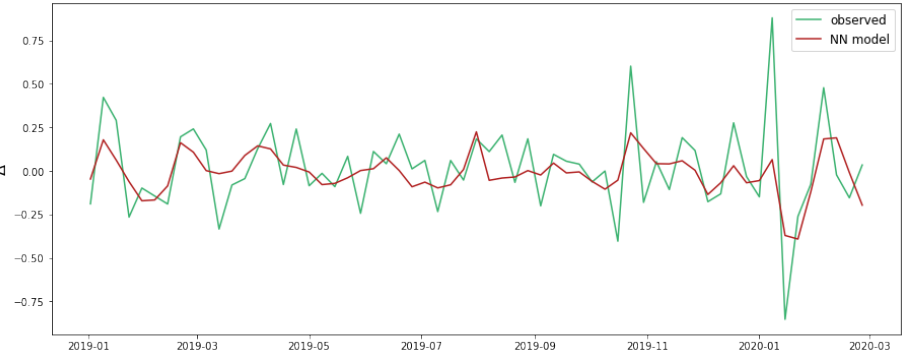
Figure 9. Comparison of NN forecasts and observed data for price variations in the test set, for product 3. The corresponding RMSE is 0.200.